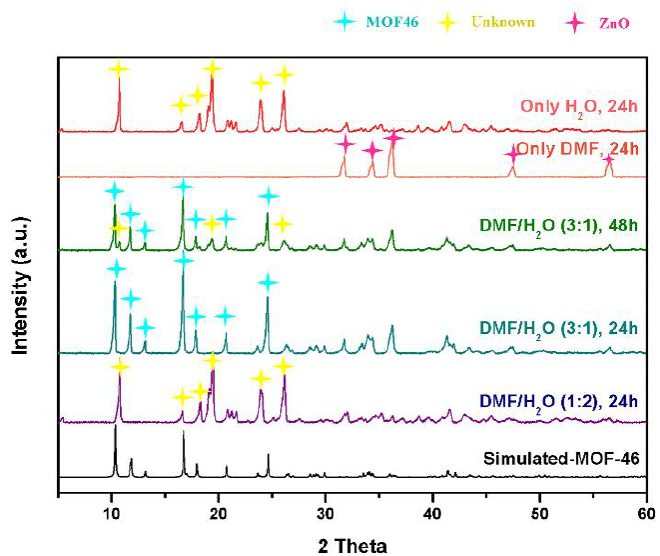
Figure 12. XRD patterns of synthesized MOF-46(Zn) and simulated MOF-46(Zn).